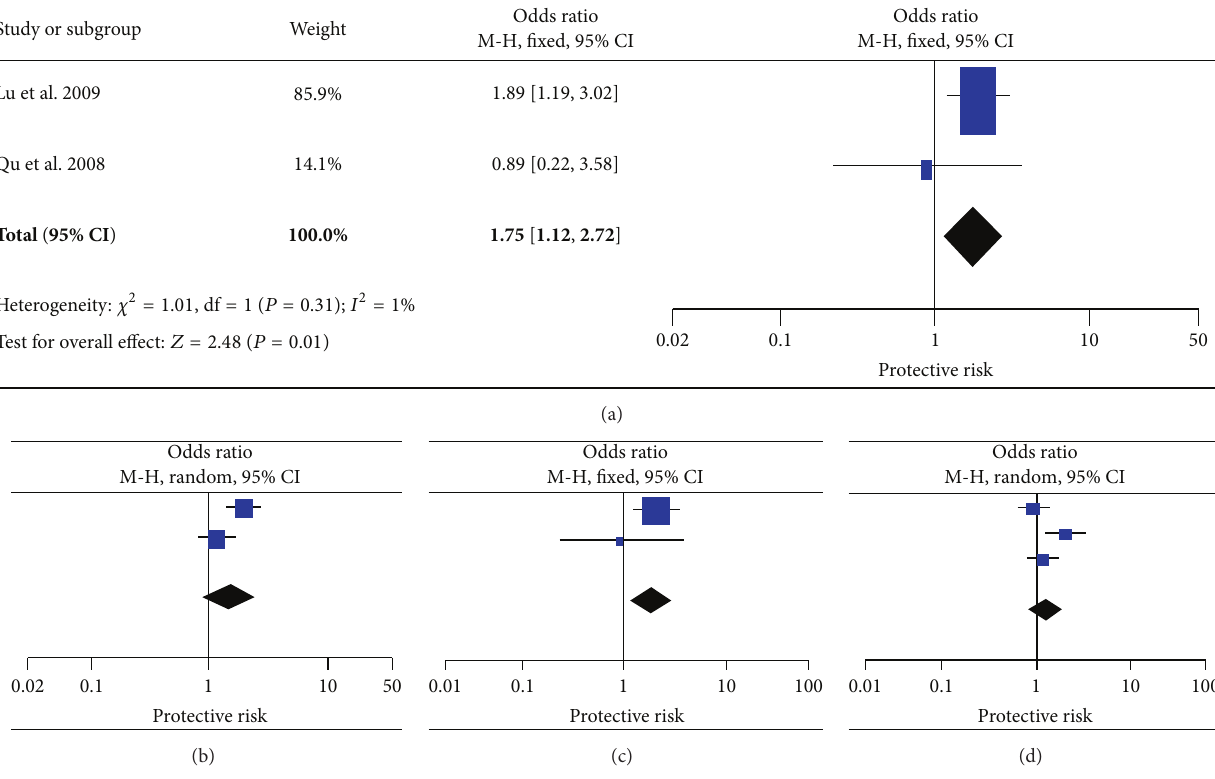
Figure 5: Forest plots of the association of LEPR p.P1019P with T2DM. (a) Recessive model, (b) allele model, (c) homozygote model, and (d) dominant model (study by Takahashi-Yasuno et al. only provides dominant data for this